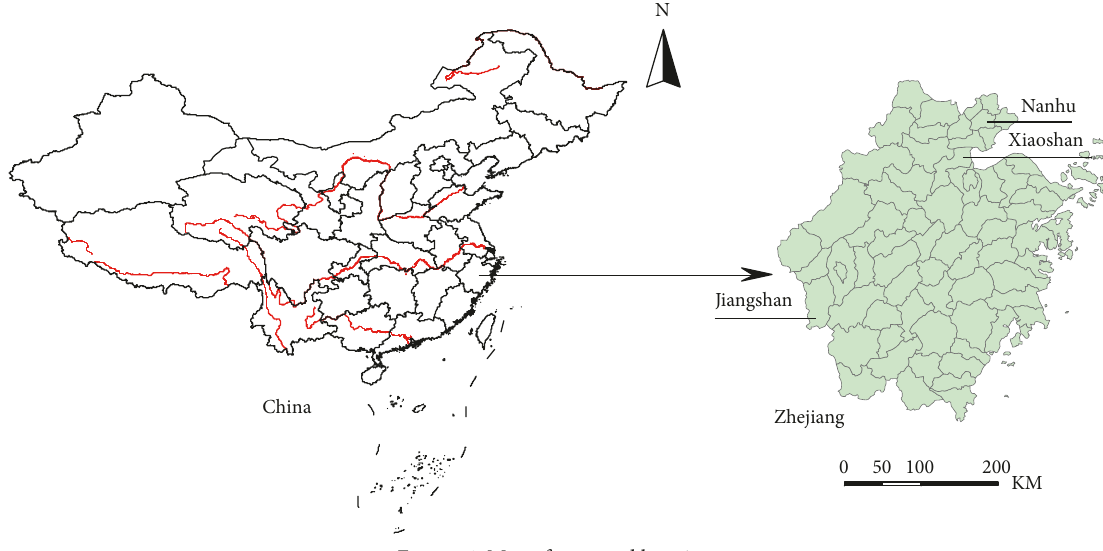
Figure 1: Map of surveyed